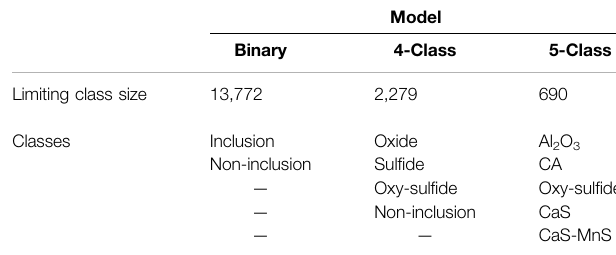
TABLE 2 | Summary of inclusion models, relevant classes, and limiting class